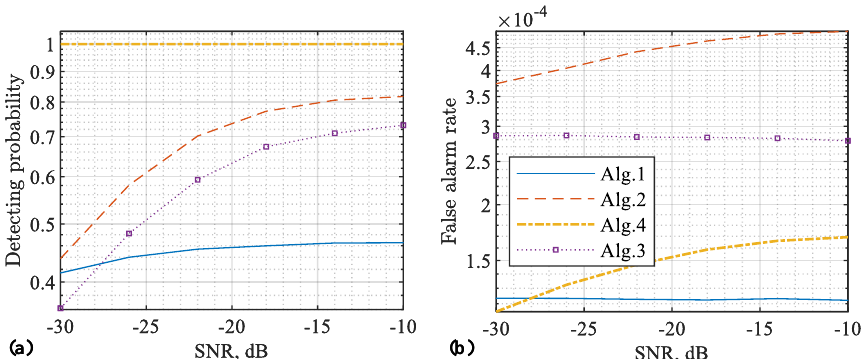
Figure 8. Detecting performance versus SNR (with respect to y ), where a single target is set with randomly generated parameters over 10 4 independent trials. The detecting probability is given in ( a ) and the false alarm rate is given in ( b ). Note that Algorithms 1 and 2, as developed in [21,32], respectively, are simulated as benchmark methods. Additionally note that Algorithm 2 [21] cannot properly sense a target with the echo delay over the CP duration, and hence its detecting probability is much lower than our algorithms. Please note that the symbol “-” before all numbers, as automatically generated by MATLAB during plotting the figure, denotes the negative